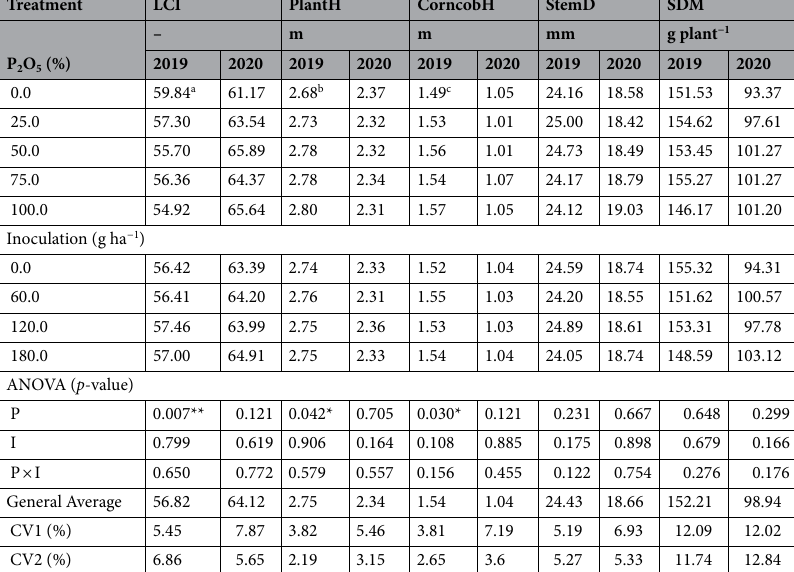
level when compared with no application of P 2 O 5 (Supplementary Fig. 3B). In 2020, there were no effects of the analyzed factors on plant height, which were lower than those in the previous year, with an average height with no P 2 O 5 addition (Supplementary Fig. 3C). In 2020, however, there was no effect of phosphate fertilization and mycorrhizal inoculation, with an average value of 1.04 m. In both years of the experiment, there was no effect of the treatments on the diameter of the thatch, with aver- ages of this variable in 2019 and 2020 being 24.43 mm and 18.66 mm, respectively. The shoot dry matter mass also did not show significant modifications as a function of the treatments with P and AMF, with the average values being 152.21 g plant −1 in 2019 and 98.24 g plant −1 in 2020. Corncob length was significantly influenced by mycorrhizal inoculation in 2019 ( p < 0.05), without the bio- logical significance of a regression equation fit (Table 3). In 2020, there was no effect of treatment on this variable. The averages for 2019 and 2020 were 16.48 cm and 14.61 cm, respectively. In the first year of the experiment, there was an effect of inoculation with AMF on the diameter of corncobs (p < 0.05), with a fit to a quadratic regression equation (R 2 = 72.62%) and maximum point at the applied amount of 65 g ha −1 of the inoculant, resulting in 5.03 diameter of diameter, an increment of 1.6% compared to no treatment (Supplementary Fig. 4A). In 2020, this variable was not affected by phosphate fertilization or inoculation with AMF, with the overall average being 4.04 cm, lower than that in 2019. Phosphate fertilization and mycorrhizal inoculation also did not affect the number of rows per corncob in the two years of the experiment, with averages of 16.69 and 16.51 rows per corncob in 2019 and 2020, respectively. The number of grains per row were benefited by inoculation with AMF ( p < 0.05) in 2019, with quadratic regres- sion equation fit (R 2 = 84.12%).The maximum grains per row (35.23) were achieved after AMF application of 81.65 g·ha −1 (Supplementary Fig. 4B), which is 2.23% more than the mean at zero inoculation (34.46 grains per row). In 2020, this variable was not influenced by the treatments, with an overall average number being 33.17 grains per row. Phosphate fertilization and mycorrhizal inoculation did not have significant effects on dehusked corncob mass, grain mass per ear, and cob mass. The mean of these three variables for 2019 were 162.53 g, 141.47 g, and 21.06 g, respectively; in 2020, they were 111.25 g, 95.43 g, and 15.75 g, respectively. However, there was a signifi- cant difference in the average values obtained during the two years of the experiment (Table 4). Similarly, the thousand-grain mass and grain yield were not influenced by different amounts of P addition and mycorrhizal inoculation in 2019 and 2020 (Table 4). In 2019, the mean values for thousand-grain mass and yield were 303.65 g and 8390 kg ha −1 , respectively. In 2020, the values were 175.74 g and 3865 kg ha −1 , respectively. Multivariate principal component analysis for the variables analyzed in 2019 (Table 5), allowed the identi- fication of two principal components with eigenvalues greater than 1.0 (2.85 and 1.50 for components 1 and 2, respectively). The principal components (PC) allow understanding relationships between phosphate fertilization